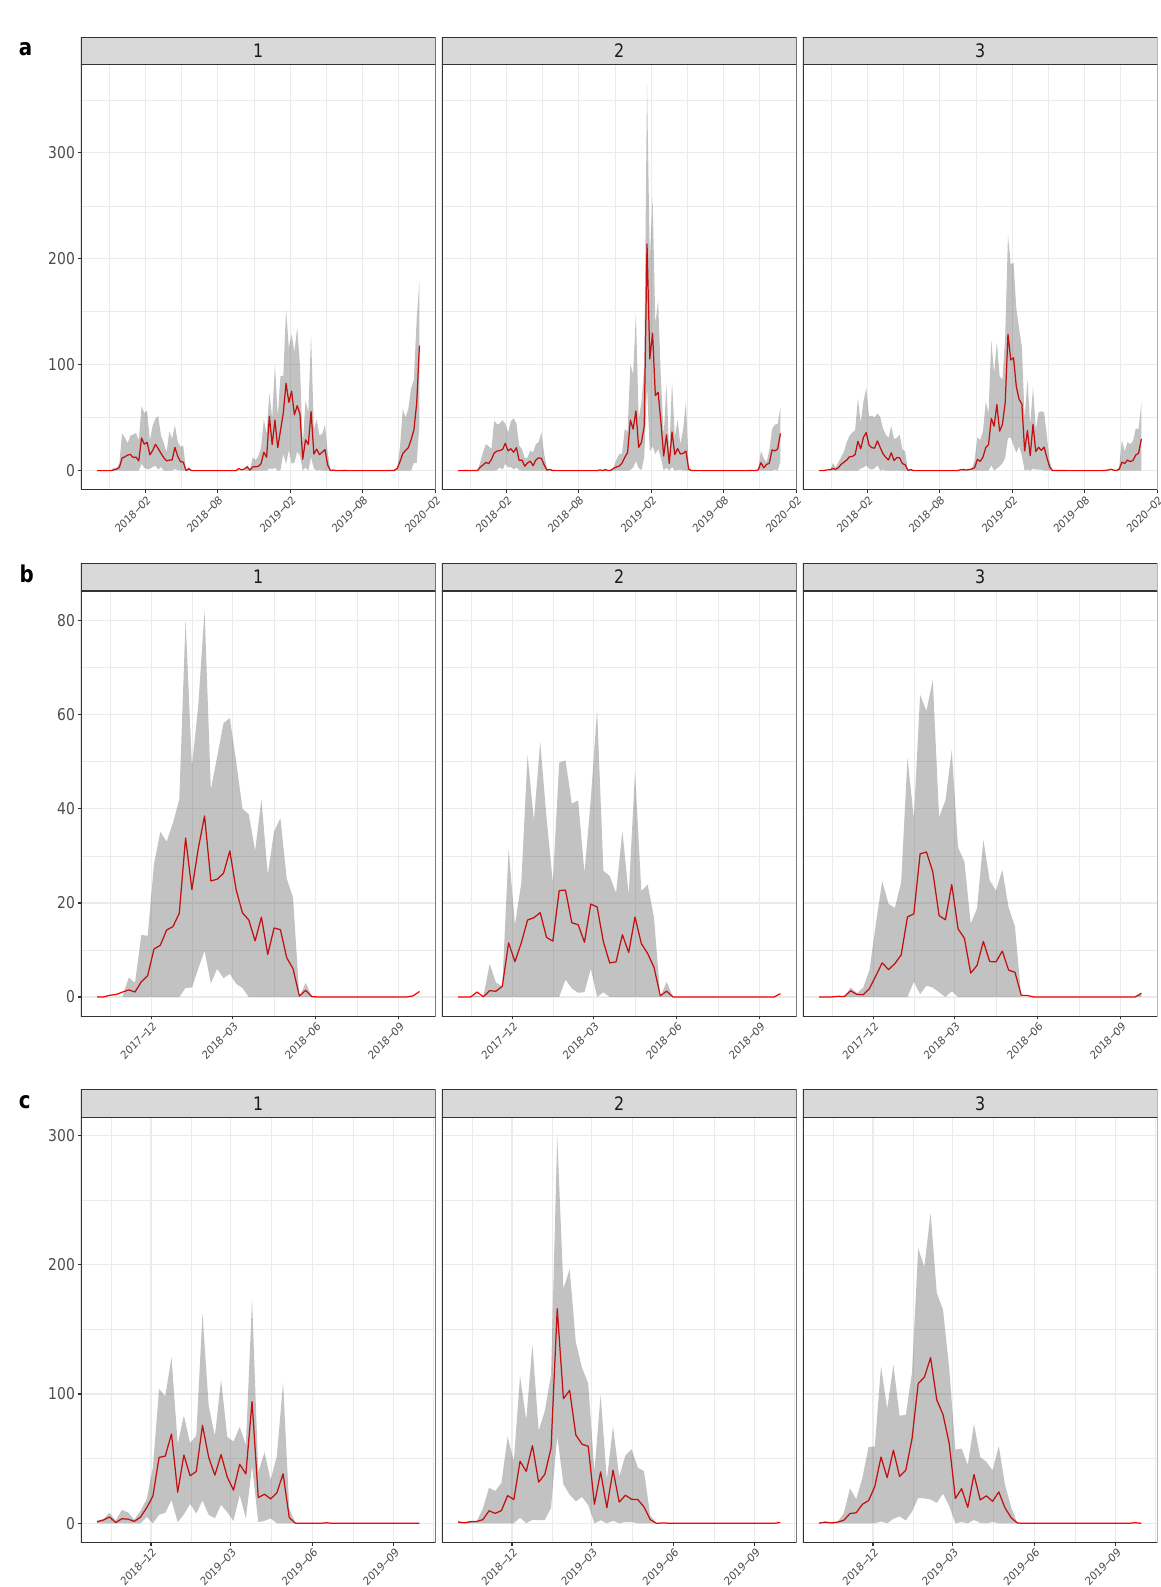
Figure 4. Mean egg count (red line) of the clusters obtained for ( a ) the full series, ( b ) 2017–2018 and ( c ) 2018–2019. Clustering groups are in columns. The gray area represents the 10th and 90th